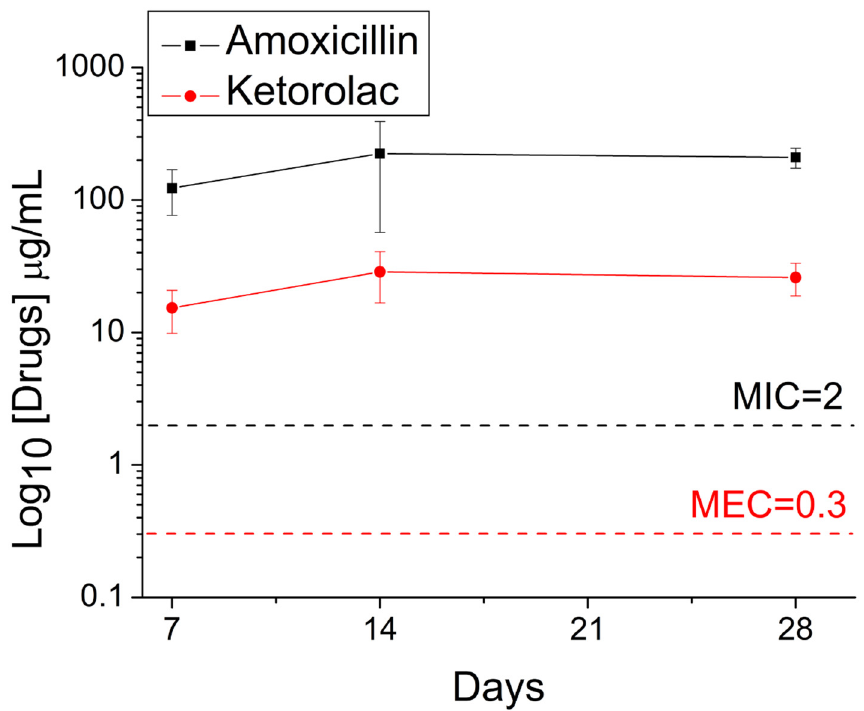
Figure 10. In vivo release of pharmaceuticals from the nanofibers. The minimum effective concen- tration of ketorolac was 0.3 μ g/mL, and the minimum inhibitory concentration of amoxicillin was 2 μ g/mL [36,37].